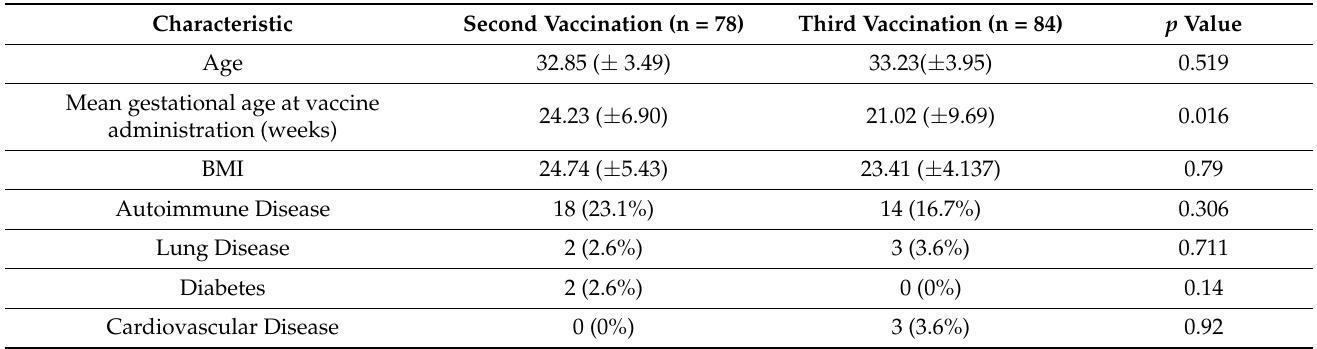
Table 1. Baseline characteristics of 78 pregnant women who received a second dose and 84 pregnant women who received a third (booster) dose of BNT162b2 vaccine.